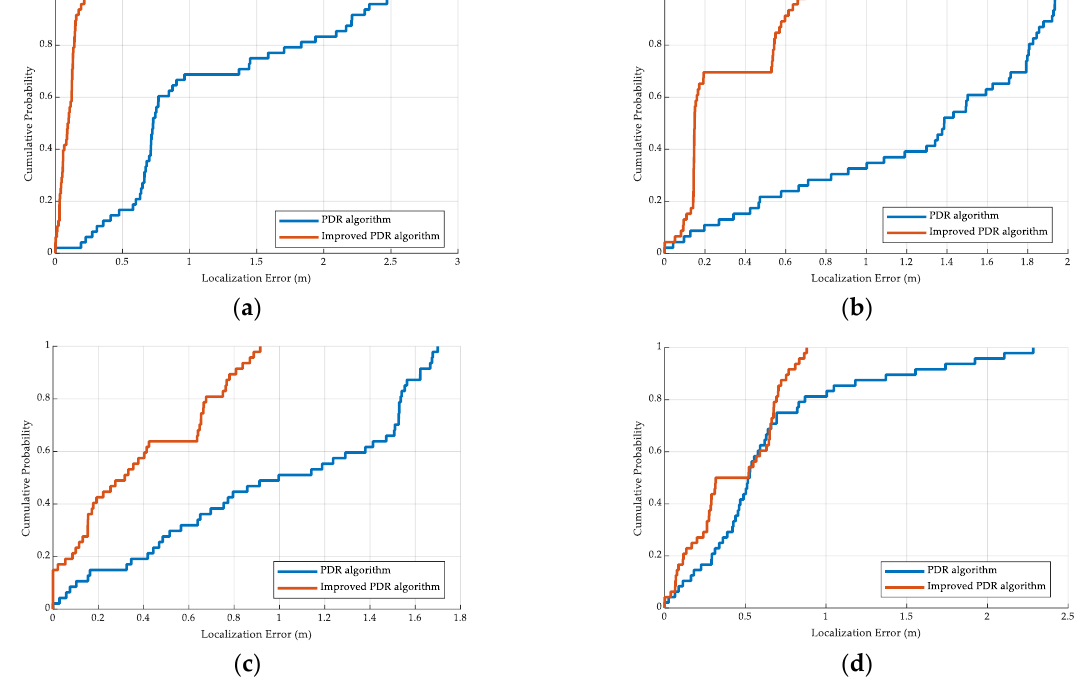
Figure 11. The CDF of localization errors between our PDR and PDR algorithms in the first scene. ( a ) Volunteer #1 with a VivoY85a cell phone. ( b ) Volunteer #2 with a VivoY85a cell phone. ( c ) Volunteer #1 with an Honor60 cell phone. ( d ) Volunteer #2 with an Honor60 cell phone.